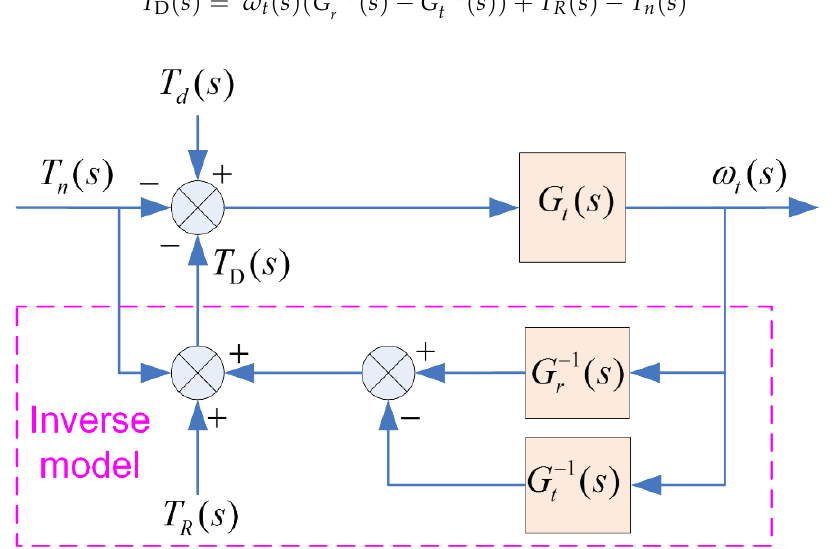
Figure 5. Control schematic diagram of IMD principle.